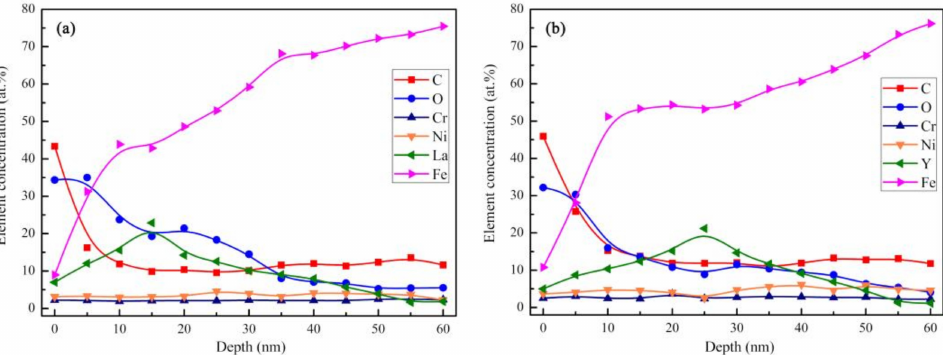
Figure 5. Depth profiles of element content distribution obtained by XPS—( a ) lanthanum implantation result and ( b ) yttrium implantation